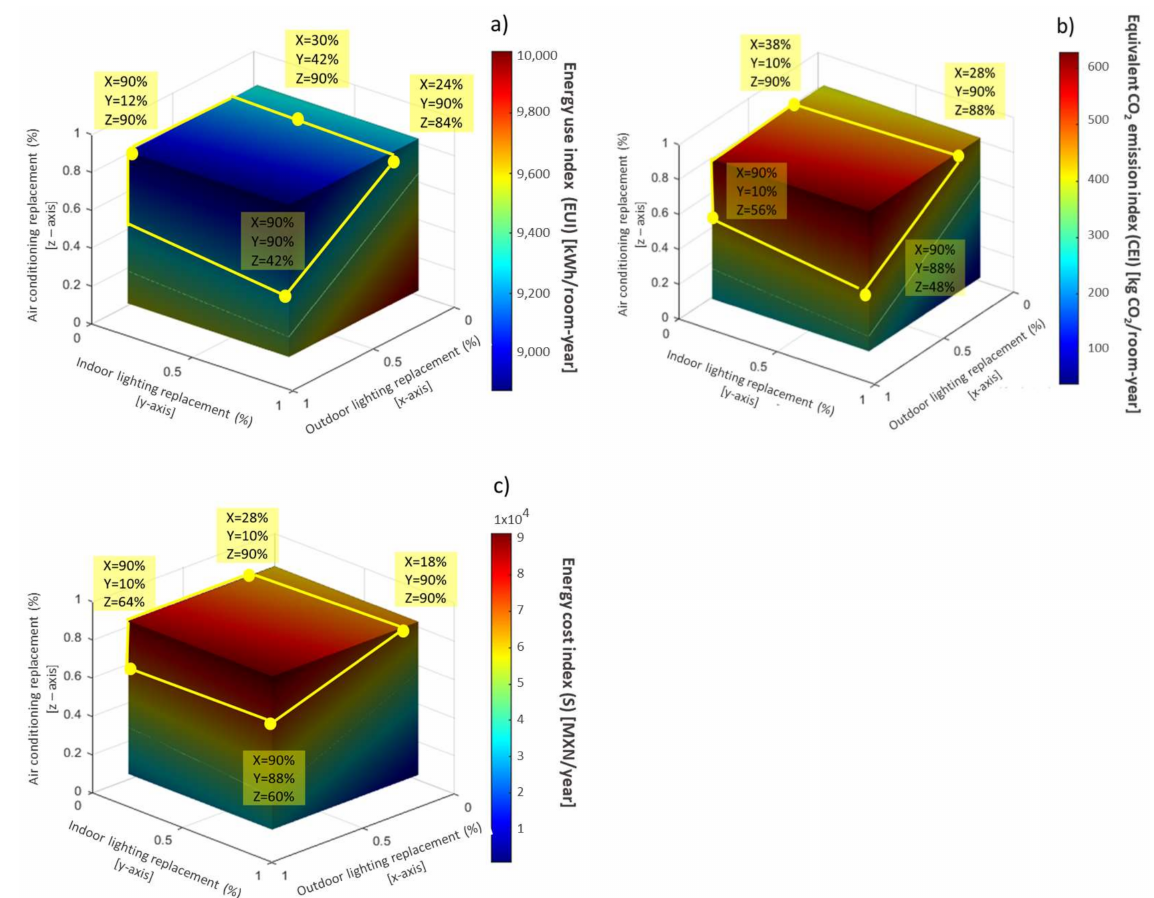
Figure 7. Effects of percentages of technological substitution of indoor lighting, outdoor lighting, and air conditioning on the indicators of interest: ( a ) energy-use index; ( b ) equivalent CO 2 emissions; ( c ) energy-cost